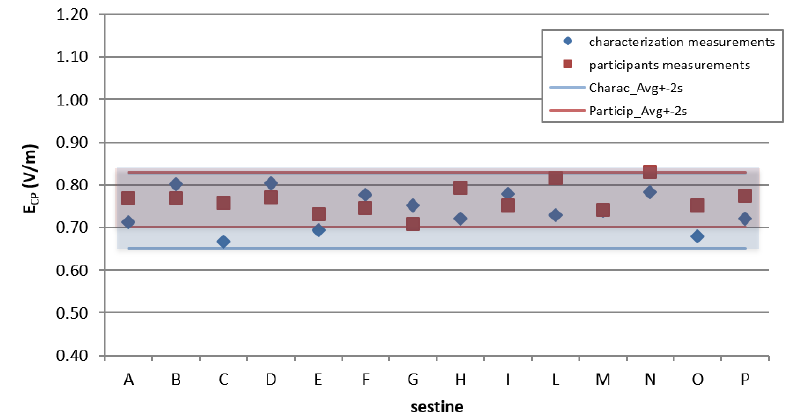
Figure 4. Graphical representation of the results of characterization measurements (sestet) and those of participants in CP mode with their variability ranges.